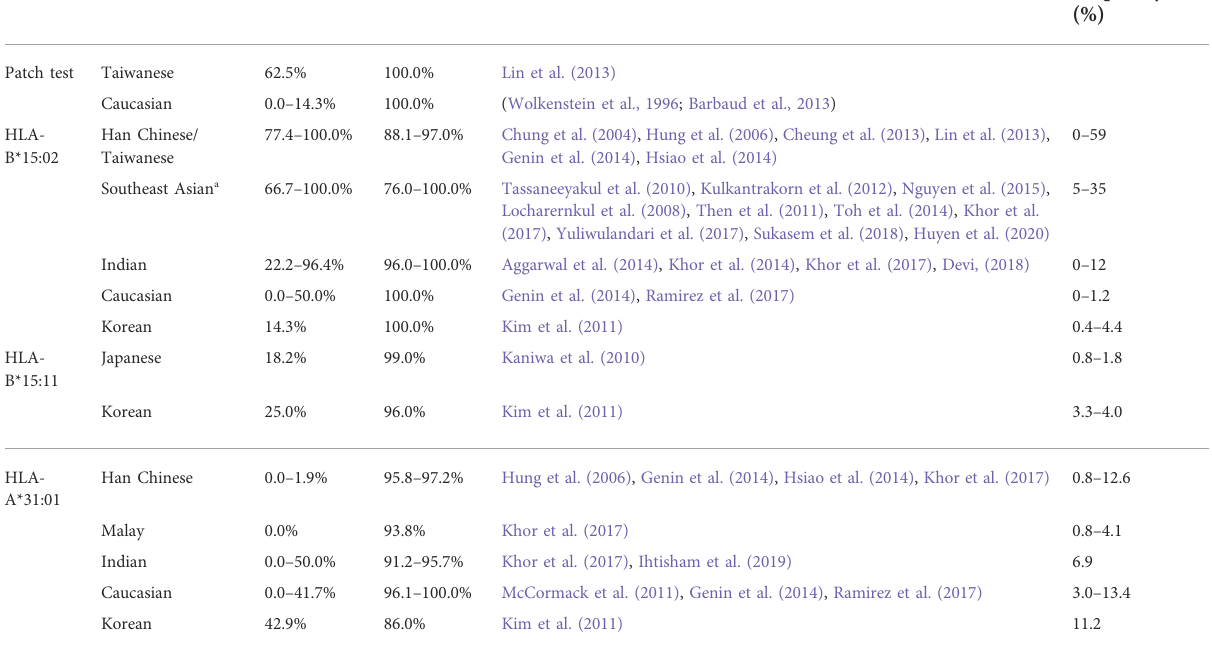
TABLE 1 Sensitivity and speci fi city of patch tests and HLA tests for carbamazepine-induced